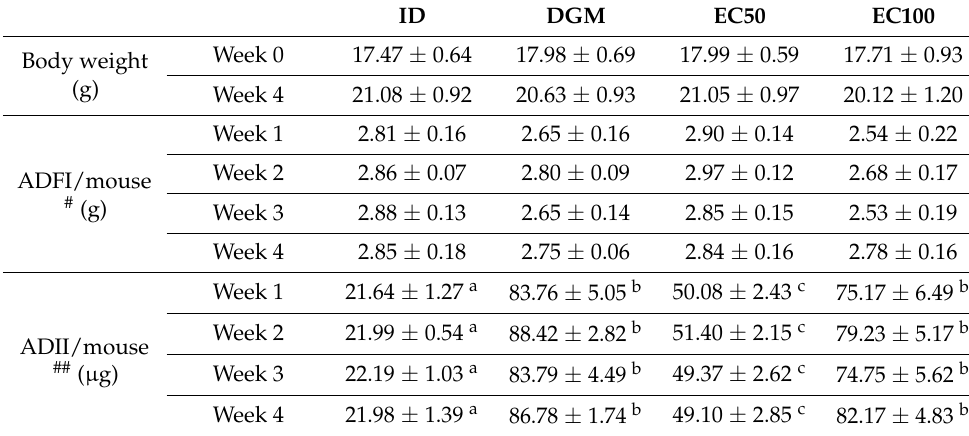
Table 3. Growth performance of mice fed different iron-fortified diets